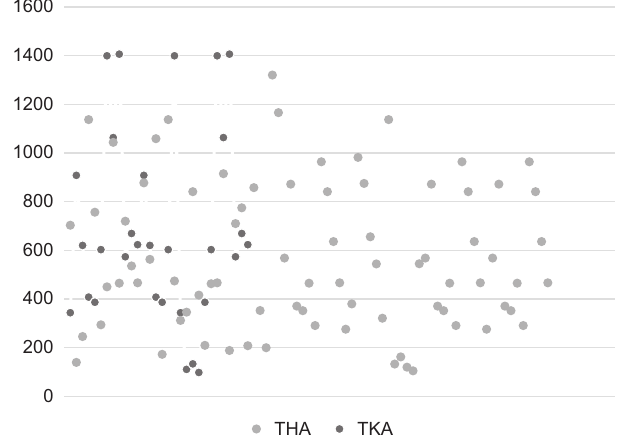
Figure 4. Scatter plot of CD4+ T-cell count in HIV-positive total joint arthroplasty